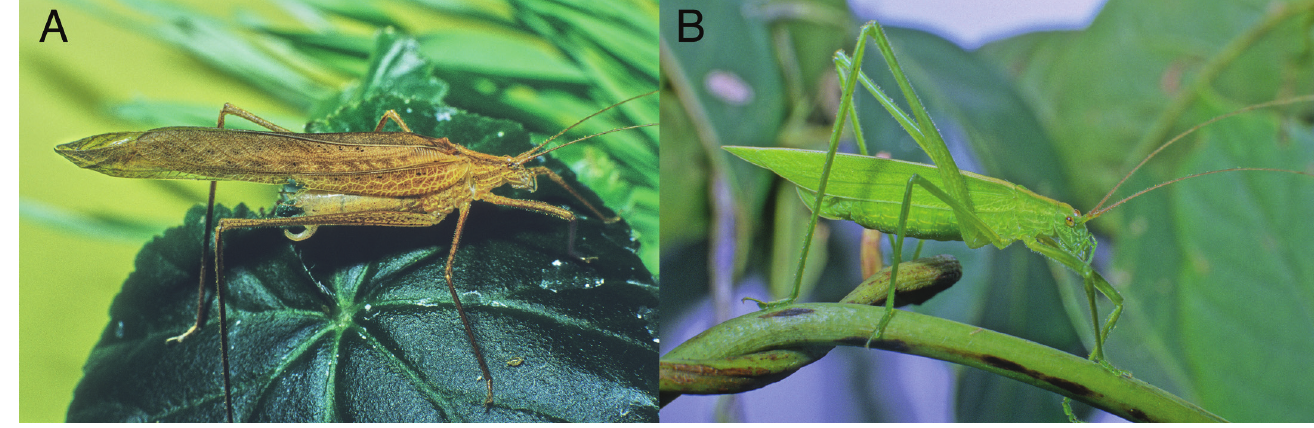
Figure 15. Habitus of Ectadia fulva. A. male, B. female .